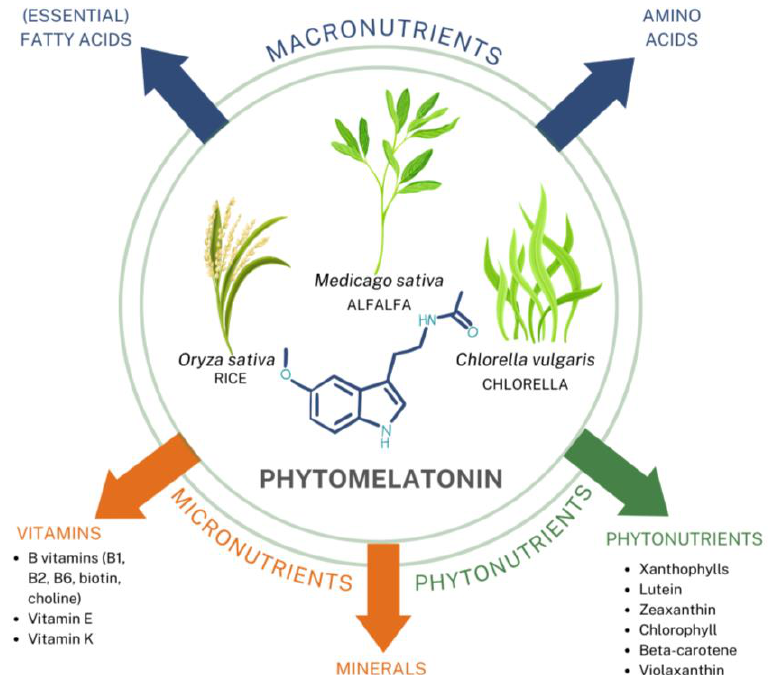
Figure 7. Nutritional characteristics of phytomelatonin. The phytomelatonin detailed below refers to the proprietary format utilized in [34]. Graphic created using Canva.com using images from pavelnaumov (chlorella, alfalfa), Victoria Sergeeva (rice), and Walrus_d’s (melatonin). Canva.com accessed 27 July 2022.